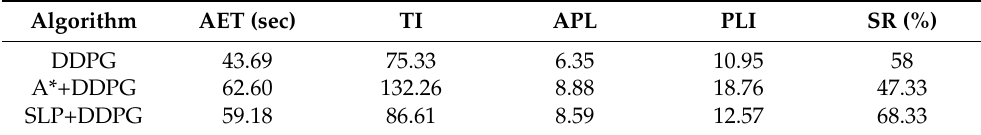
Table 3. Test Case 3 (Large-Scale Dynamic Environment).